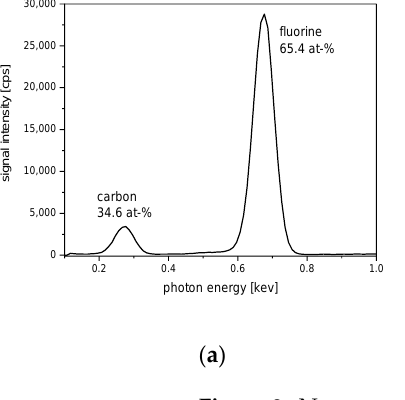
Figure 9. Non-woven filter materials from PTFE fibers—( a ) EDS spectrum of this PTFE material; ( b ) SEM image of this PTFE